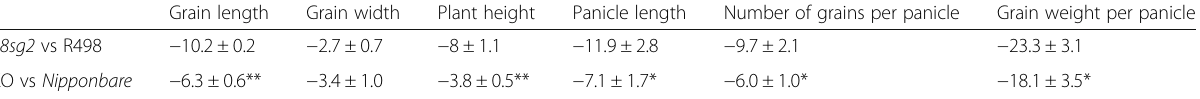
Table 1 Comparisons of the reduction percentage of 08SG2/OsBAK1 mutation in indica and japonica backgrounds Grain length Grain width Plant height Panicle length Number of grains per panicle Grain weight per panicle 08sg2 vs R498 Reduction percentage (%) was calculated using the WT (R498 and Nipponbare , respectively) as control. KO indicated the average value of the four knock out mutants. Data are given as means±SD. Student ’ s t-test was used to generate the P values; * and ** indicate P <0.05 and P <0.01,